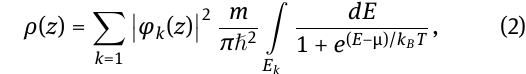
electromagnetic field, which are set to be zero in our case, and well structure.